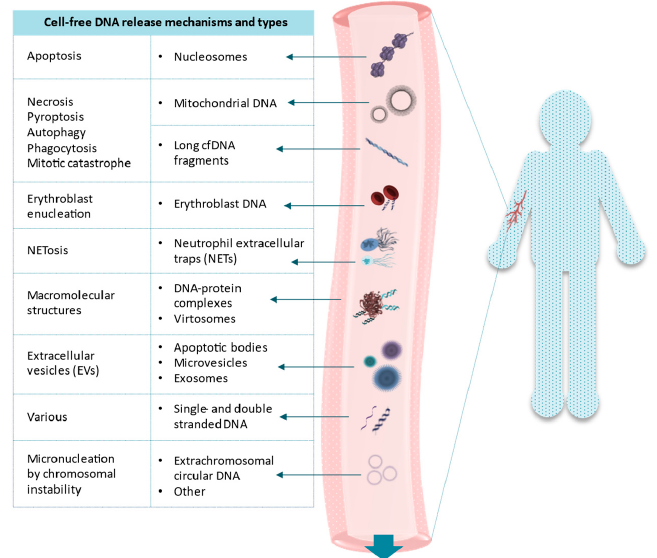
Figure 1. Di ff erent forms of cell-free DNA (cfDNA) in the human circulatory system. The biological and structural characteristics of the aggregate cfDNA population in a typical biospecimen is highly heterogeneous. While some overlap is common (see the main text), di ff erent cellular sources and mechanisms of origin often result in the production of uniquely distinct forms of cfDNA. Exhaustive stratification of the di ff erent cfDNA subtypes and an improved understanding of the factors which might modulate these characteristics of cfDNA are vital steps toward understanding the biological role(s) of cfDNA, as well as an expansion of their clinical